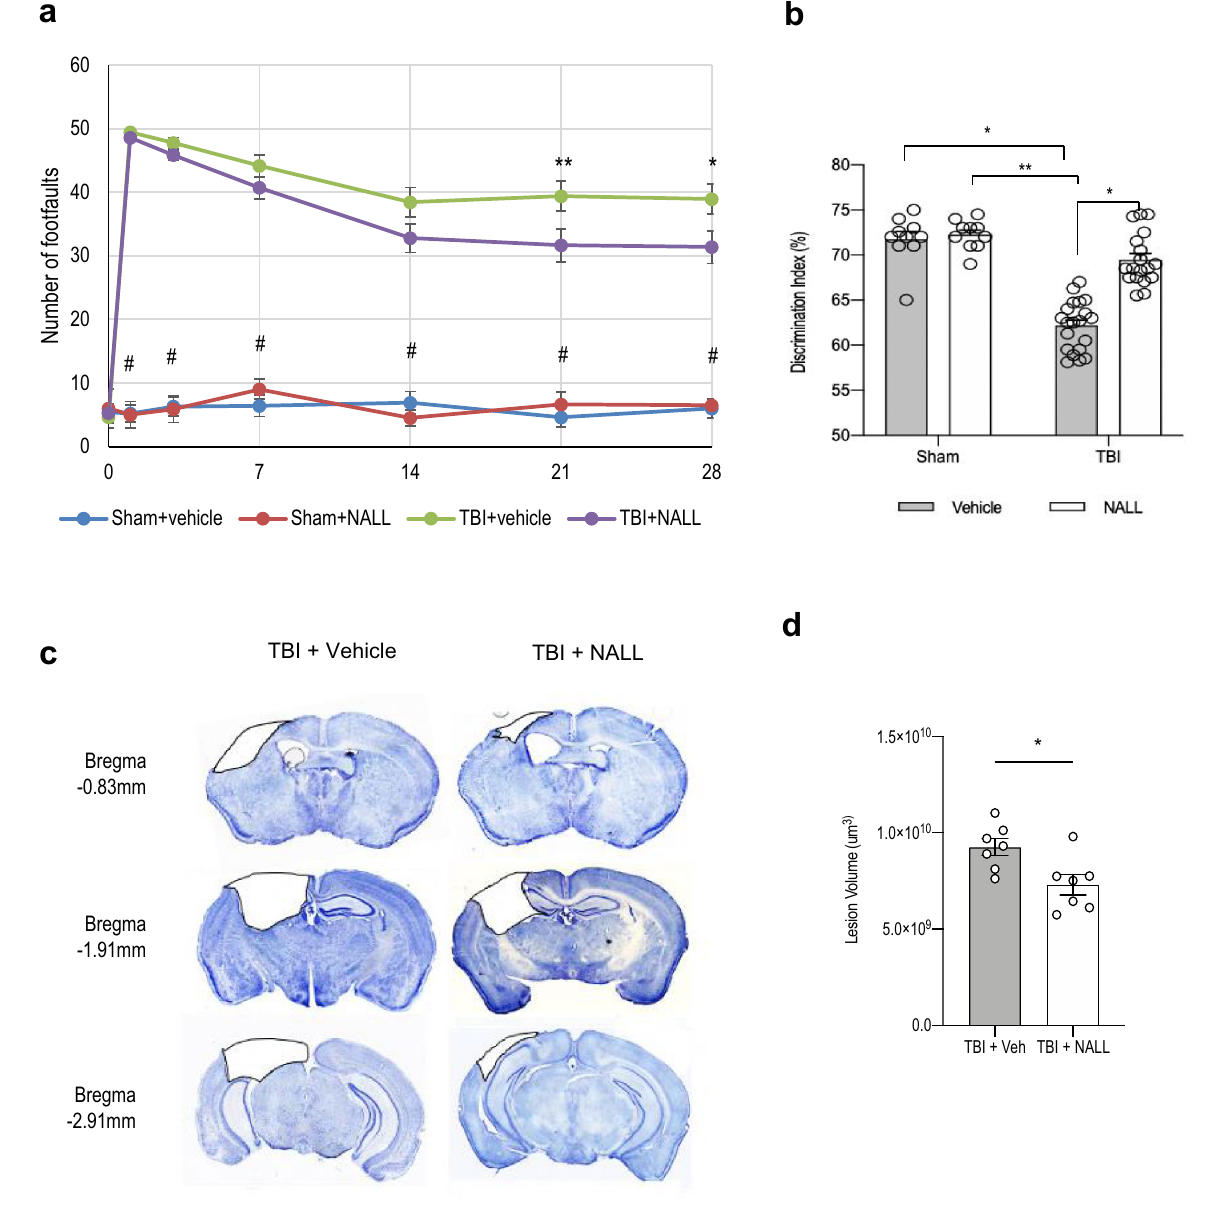
Figure 6. NALL attenuates motor and cognitive deficits and cortical tissue loss in mice after injury. ( a ) Sensory motor function was assessed in sham and TBI mice treated with vehicle or NALL using beam walk test. Number of hindlimb foot faults per 50 steps was counted on days 0, 1, 3, 7, 14, 21 and 28 after TBI. Significant injury and treatment effects were detected across all time points except day 0 (prior to injury). (Two-way repeated-measures ANOVA with Tukey’s multiple comparison test). Both vehicle and NALL-fed sham groups showed significant difference in motor function as compared to the TBI groups fed with NALL or vehicle in all time points except day 0 ( # p < 0.0001). Significant improvement in motor function was detected in NALL-fed TBI group as compared to the vehicle-treated TBI mice on days 21 (**p < 0.01) and 28 (*p < 0.05). Data are presented as mean ± SEM, n = 10 Sham + vehicle, 8 Sham + NALL, 18 TBI + vehicle and 16 TBI + NALL. ( b ) Novel object recognition (NOR) test was performed on days 24 and 25 after TBI to assess non-spatial memory retention in vehicle or NALL-treated sham or TBI mice. Vehicle-fed TBI mice spent significantly less time with novel object as compared to NALL-treated TBI mice (*p < 0.05, Two-way ANOVA). Time spent with the novel object by the vehicle-treated TBI mice was also significantly less as compared to the vehicle (*p < 0.05) or NALL (**p < 0.01) -fed sham mice. No significant difference was observed between NALL- treated TBI and either of the sham groups. Data are presented as mean ± SEM, n = 10 Sham + vehicle, 9 Sham + NALL, 20 TBI + vehicle and 18 TBI + NALL. ( c ) Representative images of lesion volume at 28 days post injury in vehicle and NALL-treated mouse cortices. Images were acquired on Leica DM4000 B TL (BF) microscope and generated using Stereo Investigator software, 2020.2.3 version (MBF Biosciences) and representative black lesion volume outlines seen in the images were traced on Microsoft Powerpoint (Version 16.42). ( d ) Stereological (Cavalieri method) quantification of lesion volume in vehicle- or NALL-fed injured mouse cortices. Data are presented as mean ± SEM. n = 7/group, *p < 0.05 (Two-tailed Student’s